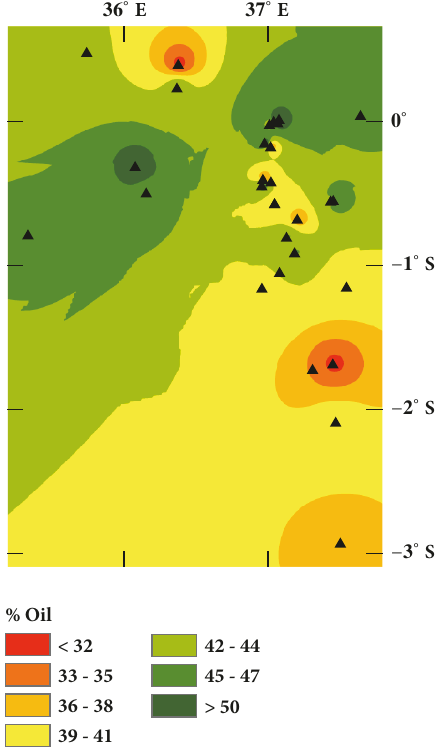
Figure 2: Interpolated map of the mass % oil in the deshelled seed after four months of storage.